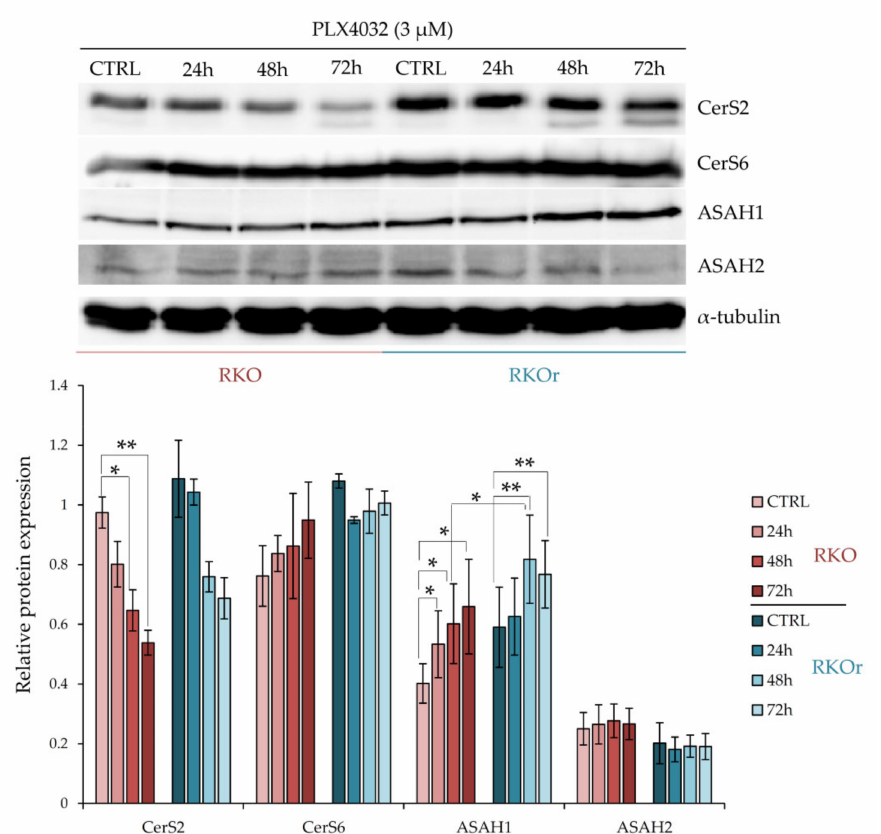
Figure 2. Time-dependent changes in relative expression of the enzymes regulating the ceramide salvage pathway in sensitive (RKO) and resistant (RKOr) cells treated with PLX4032 (3 µ M). Relative protein expression was measured using Quantity One software for densitometry analysis of western blot bands. The data represent mean and standard deviation obtained from three independent biological experiments. α -tubulin was used as loading control. Statistical significance is denoted with an asterisk (* p < 0.05, ** p < 0.01). CerS2 (ceramide synthase 2), CerS6 (ceramide synthase 6), ASAH1 (acid ceramidase), ASAH2 (neutral